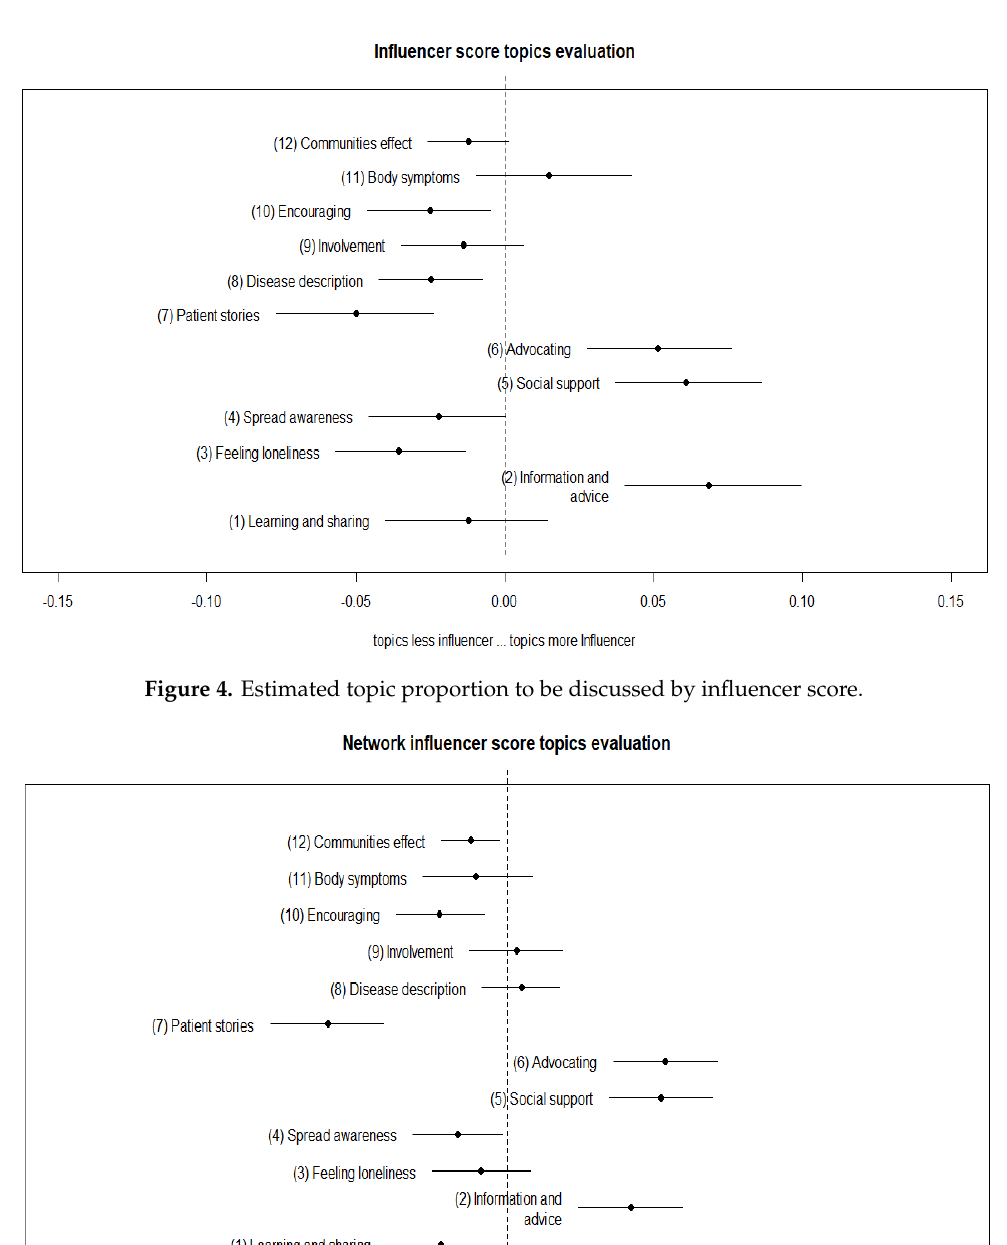
Figure 5. Estimated topic proportion to be discussed by network influencer.